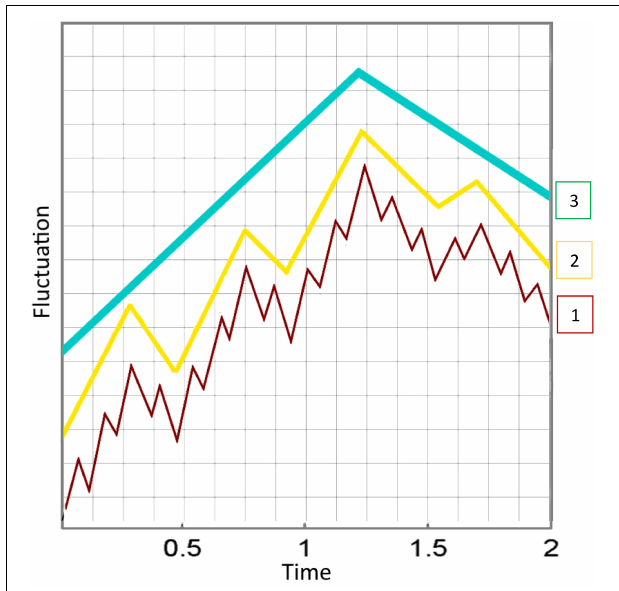
FIGURE 2 | When coarse-grained representations consolidate, new levels of organization emerge. This results in a nested hierarchy within the conscious system, each level deriving from the ones underneath. The more regularities are identified in the environment, the higher the conscious process (3 > 2 > 1). The diagram shows three different levels, from fast variables with high fluctuations to emerging levels that are increasingly slower and generalized. The different wave patterns are superimposed, but here we have separated them for a more intuitive depiction of the emergent hierarchy. This may be misleading, as this increasing regularity is continuous, or graded, and not comprising of clear-cut